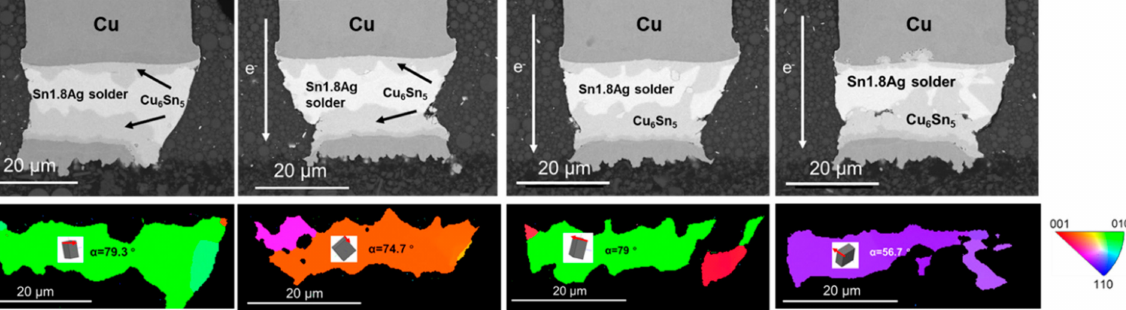
Figure 6. Microstructures of copper pillars with remained Sn after current stressing at 1.5 × 10 4 A/cm 2 at 125 ◦